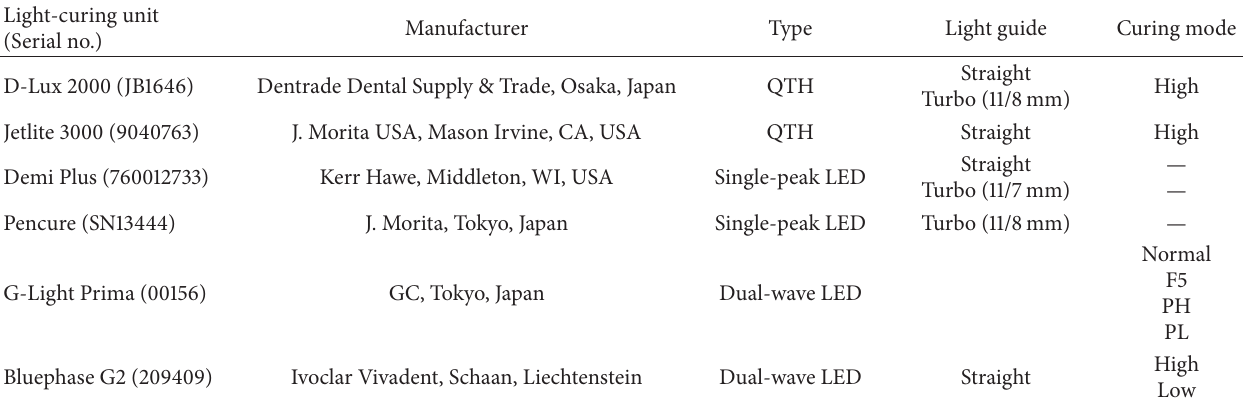
Table 1: Curing light sources used in this study.